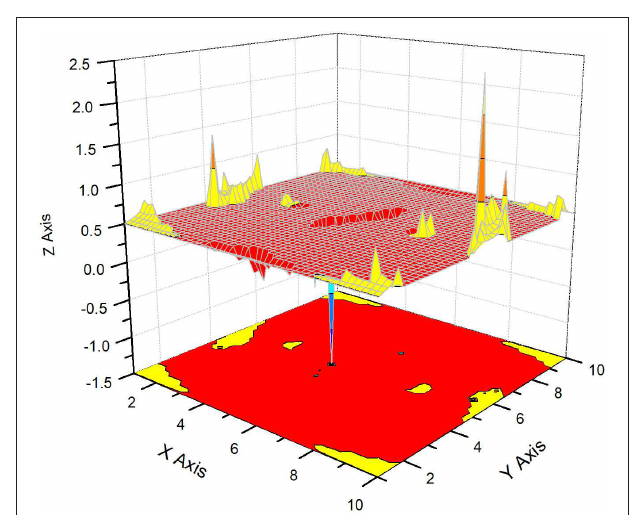
FIGURE 6 | This figure corresponds to the surface Z = y 1 ( ϕ , θ ) for the trans-number E . The scale for the angles ϕ [OX axis] and θ [OY axis] is given in the numbers of the visible data points. Each angle is digitized as X Axis = ϕ j = 2 π · ( j /10), Y Axis = θ j = π · ( j /10), j =